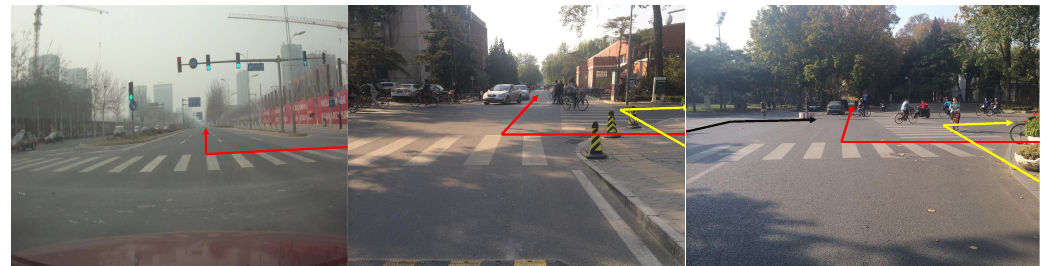
Figure 4. Presentations of pedestrian crossings in real traffic settings and their vanishing points (the location of arrow). (From left to right are the one, two, three pedestrian crossings in different traffic images and their corresponding vanishing points